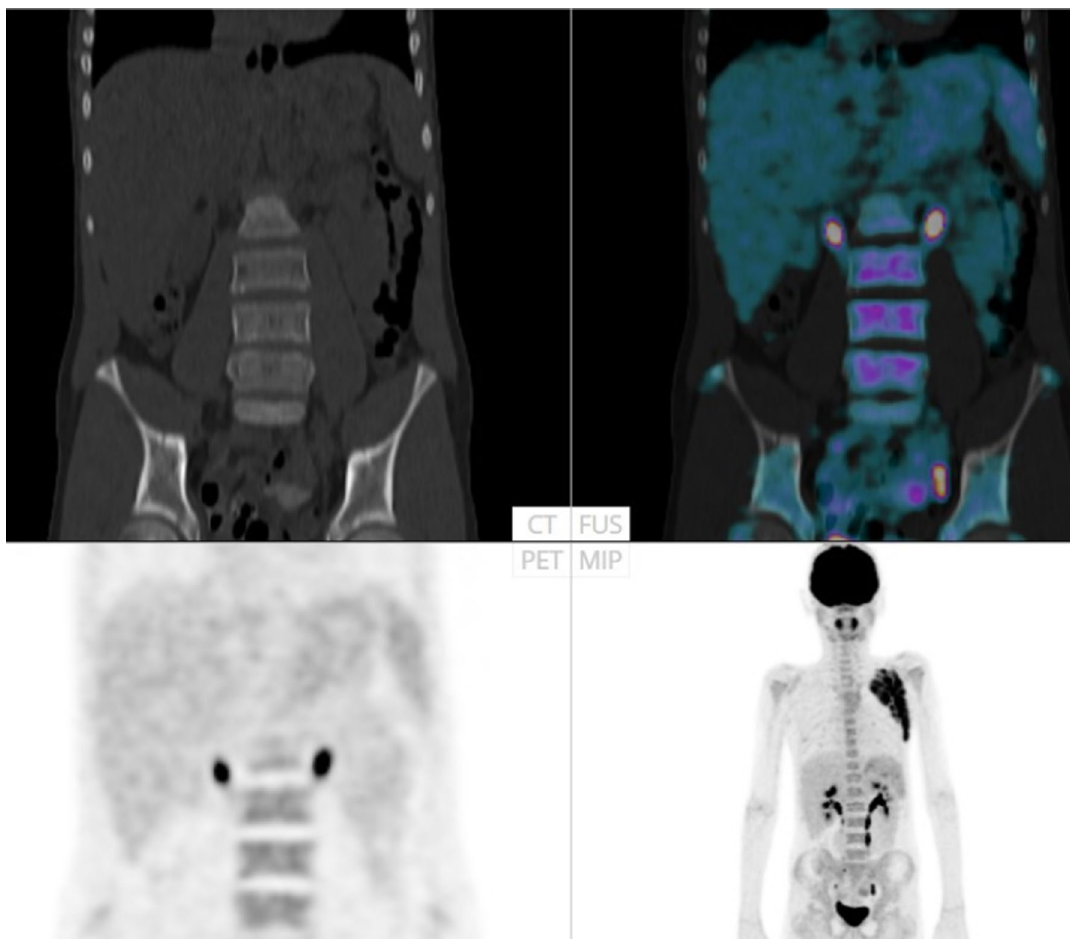
Figure 5. FDG-PET/CT: Example of a patient classified as having high diffuse bone marrow uptake (BMU) by the artificial intelligence-based method and by the manual method (SUV index of 1,7 by both methods), while the majority (6/10) of the physicians classified this case as having low